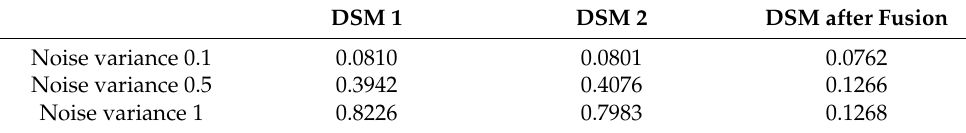
Table 2. Comparison of elevation errors before and after fusion of pitched-roofed buildings.